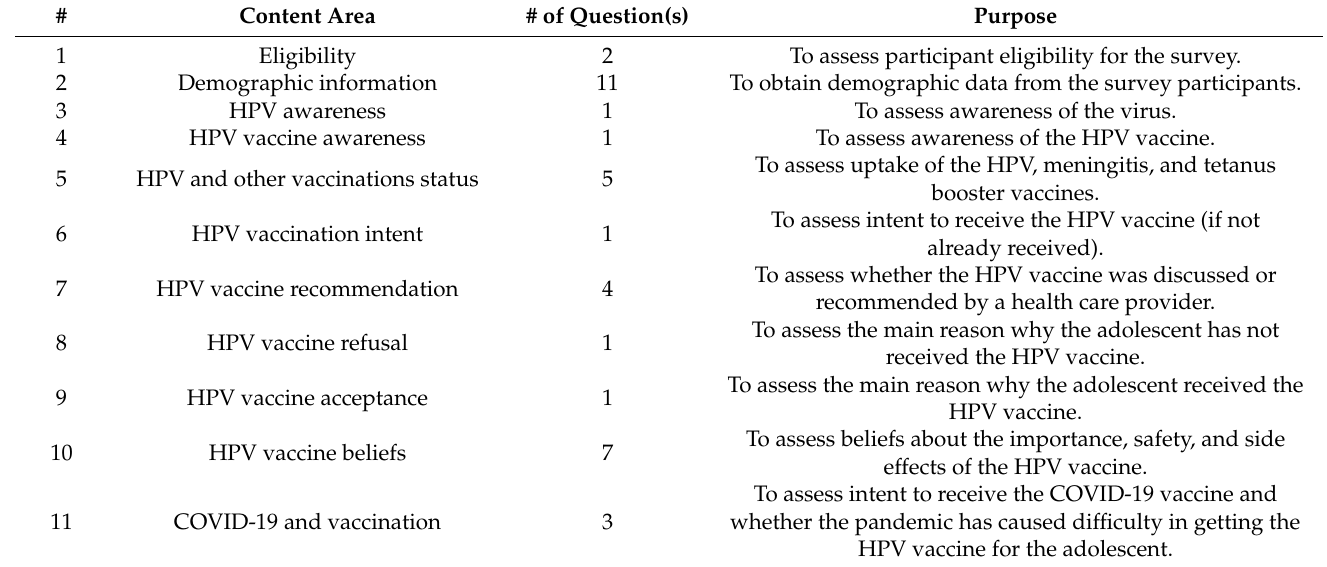
Table 2. Information about the American Indian HPV Vaccination Survey in Cherokee